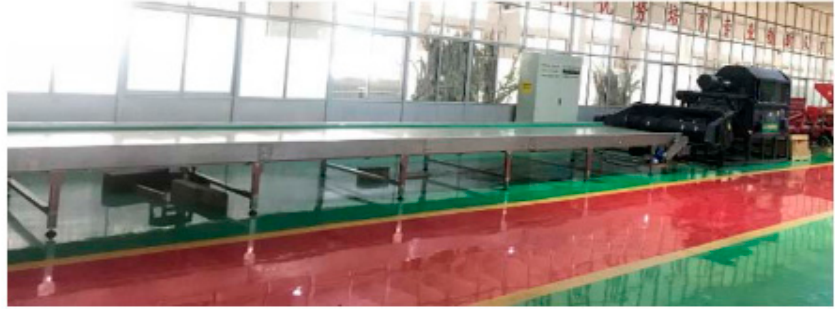
Figure 16. Experimental table for threshing and cleaning [52].